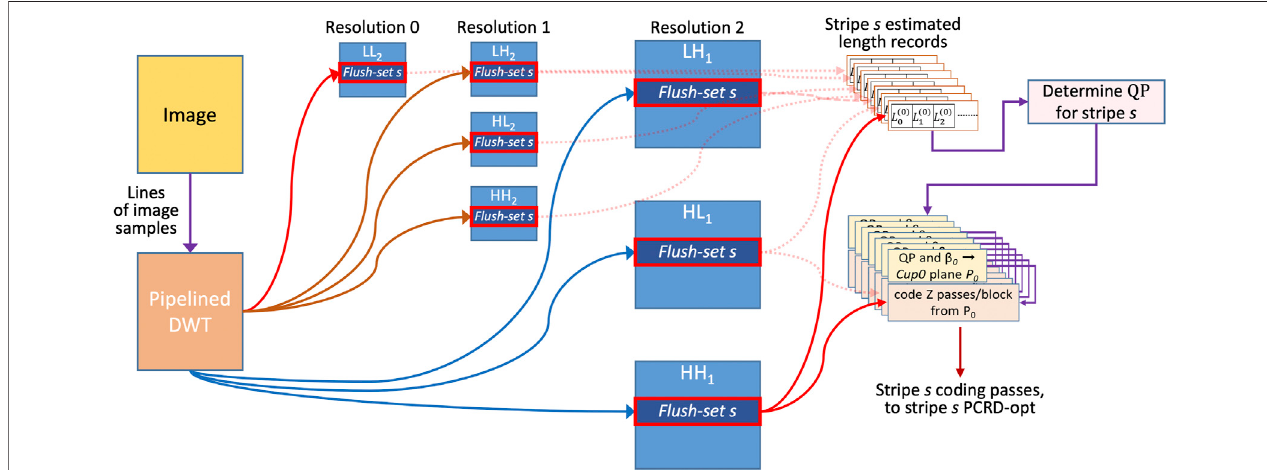
FIGURE 5 | Low-latency CPLEX-based encoding over fl ush-sets.